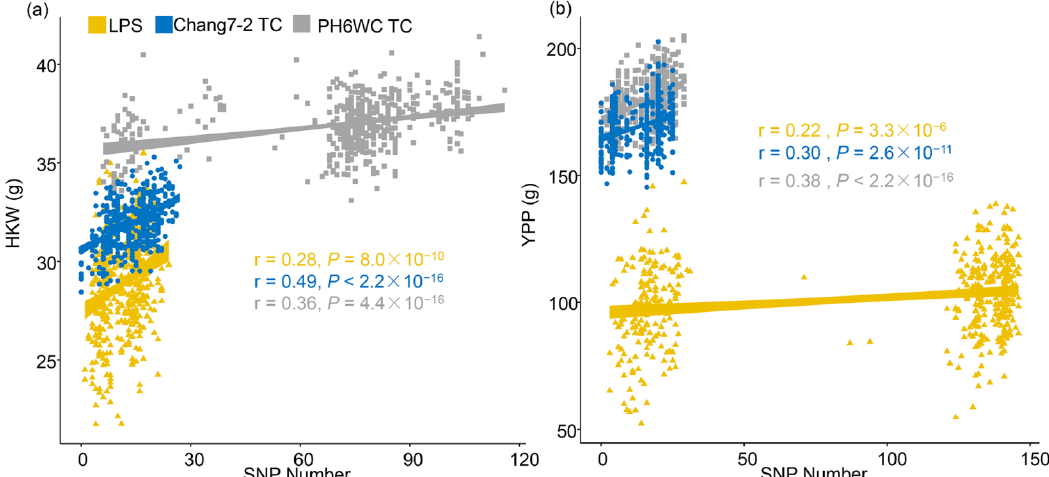
Figure 3. HKW and YPP increased with the increase of the number of favorable genotypes of significant SNPs. ( a ) showed that HKW increased with the increase of the number of favorable genotypes of significant SNPs in the LPS (yellow), Chang7-2 TC (blue), and PH6WC TC (gray) populations; ( b ) showed that YPP increased with the increase of the number of favorable genotypes of significant SNPs in the LPS (yellow), Chang7-2 TC (blue), and PH6WC TC (gray) populations. To test the effect of these significant SNPs in predicting LPS and TC performance, we performed genomic prediction (GP) and marker-assisted selection (MAS) analysis. The analysis revealed that the prediction accuracies (PAs) of GP models were larger than those of the MAS.Sig model (Figure 4a–c), suggesting that some genetic factors were not identi- fied due to the problem of false negatives for both traits in each population. We also found that the PAs of the MAS.Sig model were larger than those of MAS.Random model (Figure 4d–f) for each trait in each population, further proving that the significant SNPs were in linkage disequilibrium with the genes controlling the tested traits.